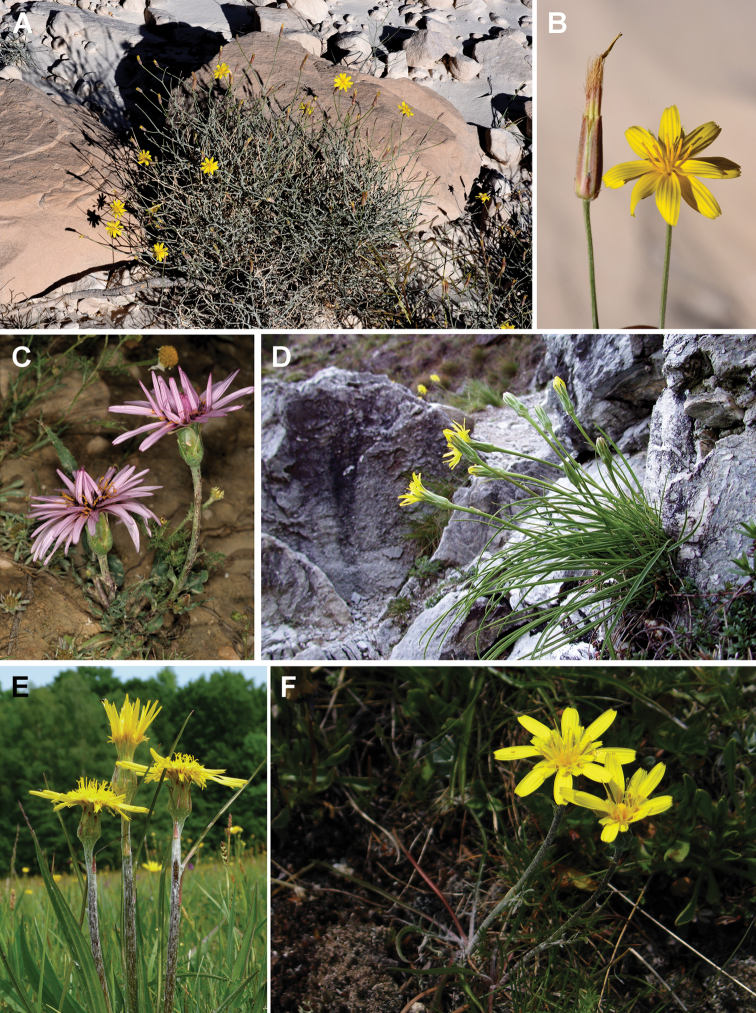
Images of living plants. A, BRamaliella
tortuosissimaA general view B close up view of the capitula (Jordan, Nakeb, 1250 m alt., 8 May 2019). Photograph by O. Fragman-Sapir CPseudopodospermum
papposum (Jordan, Nakeb, 8 May 2019). Photograph by O. Fragman-Sapir DTakhtajaniantha
austriaca (Italy, South Tyrol, Schlanders, 6 May 2010). Photograph by R. Hand EScorzonera
humilis (Germany, Ammersee, 15 May 2009). Photograph by C. Niederbichler FScorzonera
meyeri (Russia, Karachaevo-Cherkessiya, Teberda, 14 July 2005). Photograph by A.S. Zernov.